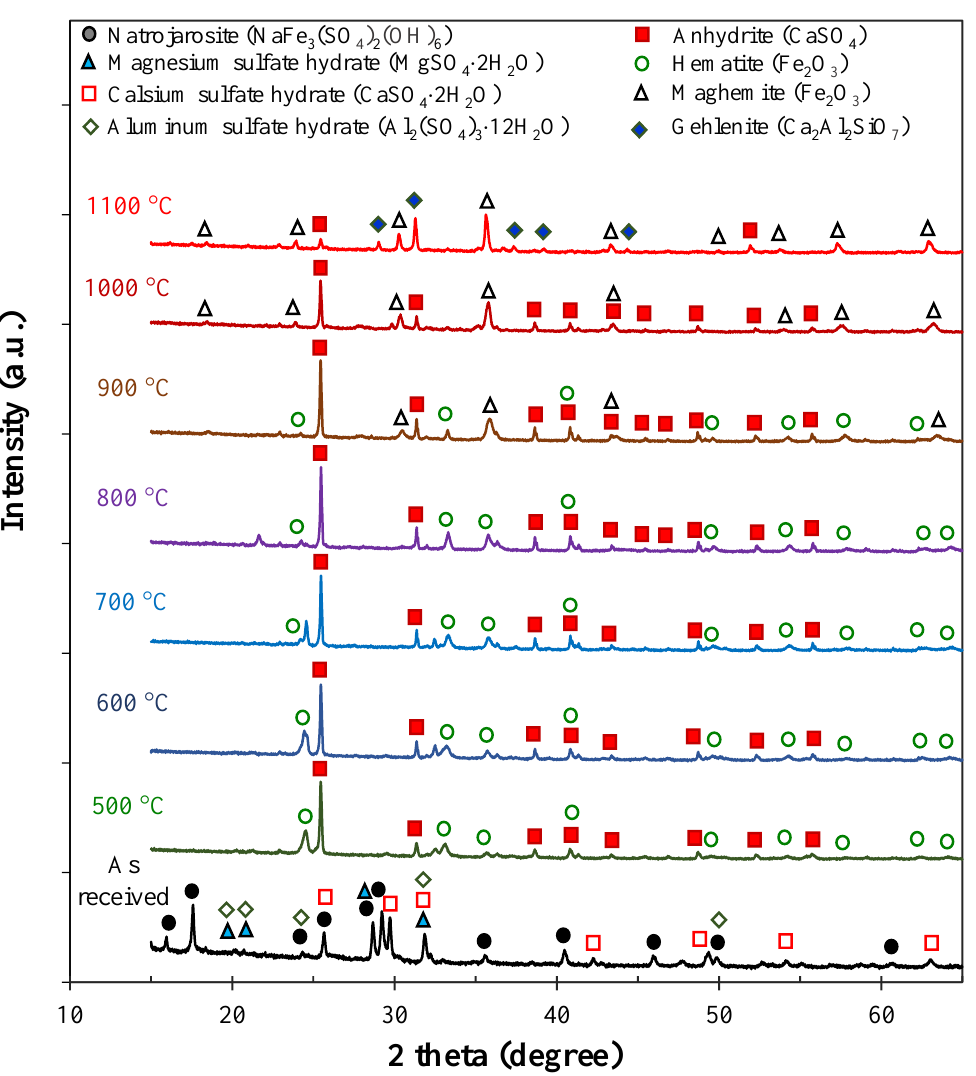
Figure 2. The results of XRD analysis on the initial and roasted samples at temperatures of 500–1100 °C.